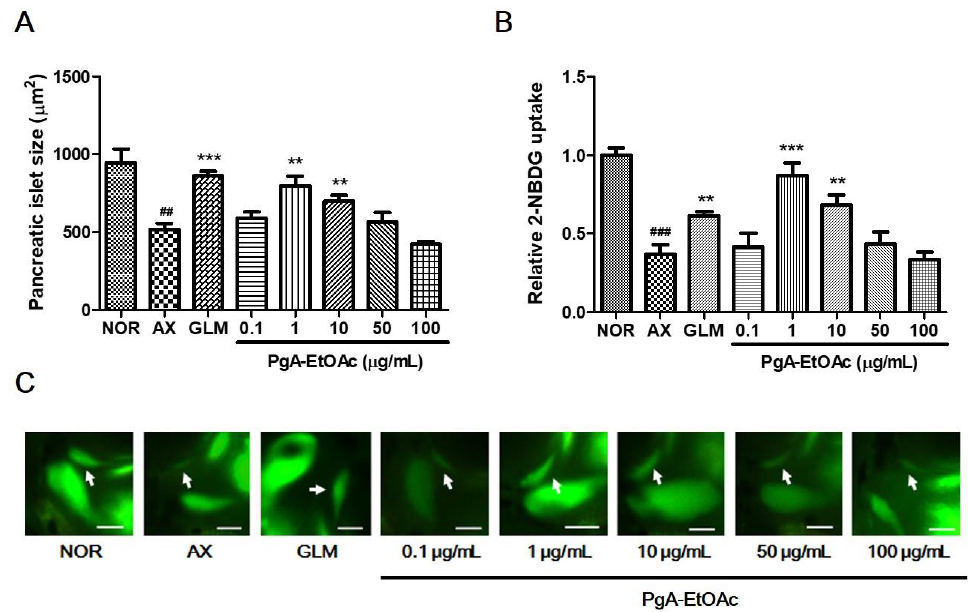
Figure 3. Dose-dependent effects of the PgA-EtOAc fraction on alloxan-induced diabetic zebrafish. ( A ) Change in pancreatic islet size caused by GLM and PgA-EtOAc fraction; ( B ) relative 2-NBDG uptake in pancreatic islet caused by GLM and PgA-EtOAc; ( C ) fluorescent microscopic images of the pancreatic islet. Scale bar = 100 μm (## p < 0.01, ### p < 0.001; compared to NOR) (** p < 0.01, *** p < 0.001; compared to AX). Scale bar = μm.